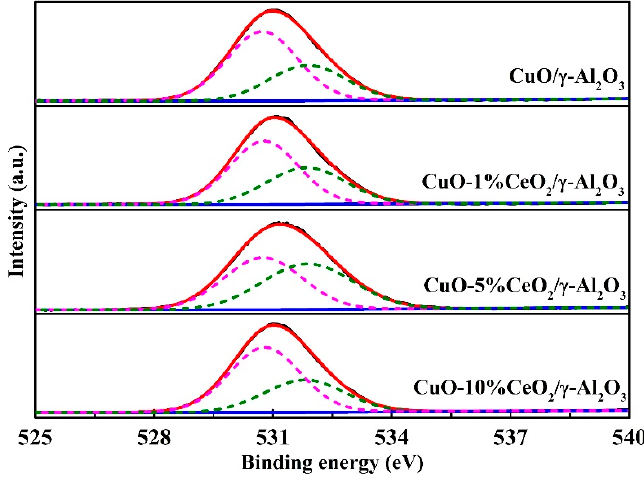
Figure 7. O1s XPS spectra of CuO/ γ ‐ Al 2 O 3 , CuO ‐ 1% CeO 2 / γ‐ Al 2 O 3 , CuO ‐ 5% CeO 2 / γ‐ Al 2 O 3 , and CuO ‐ 10% CeO 2 / γ‐ Al 2 O 3 .